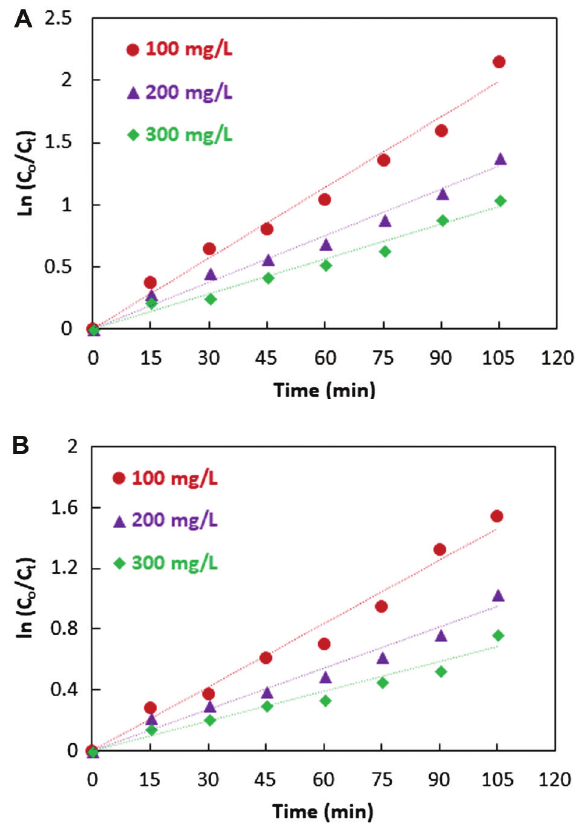
catalyzed photo degradation of Figure 7: Kinetics of Ag-TiO 2 (a) Methylene blue dye and (b) Rhodamine B dye, both with various initial concentrations.